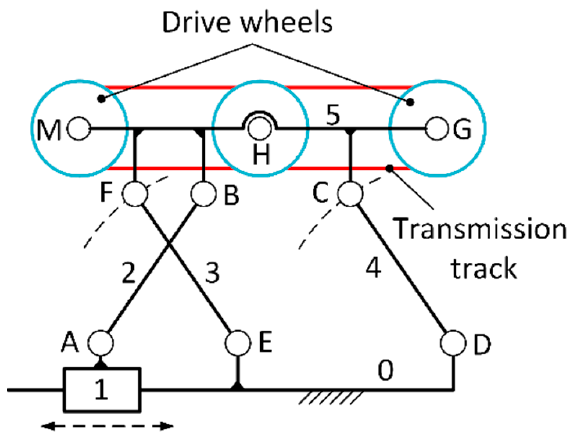
Figure 17. Adapting mechanism with belt-driven wheels.